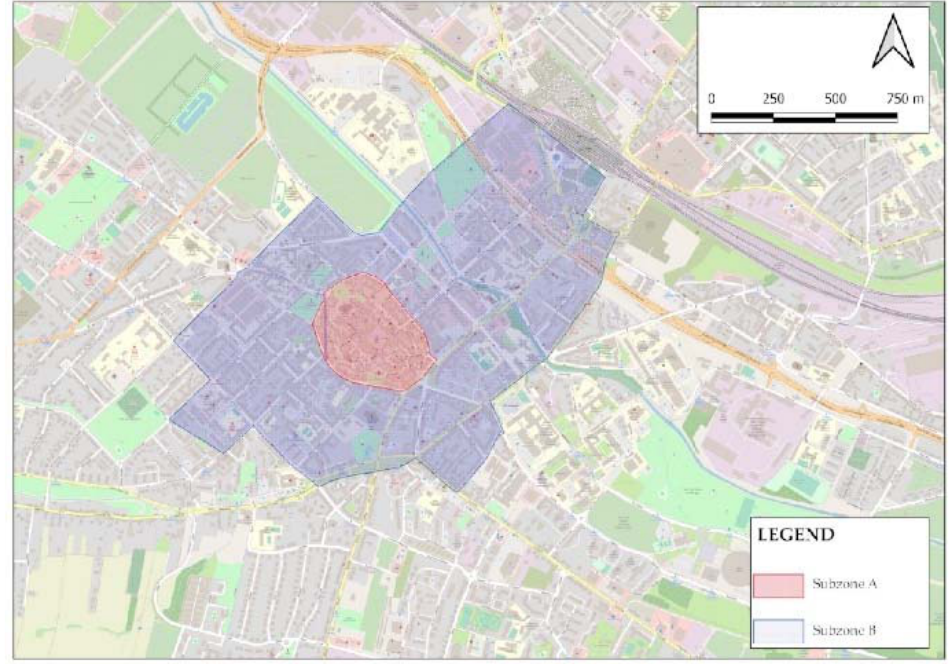
Figure 1. The paid parking zone in Gliwice divided into subzones.